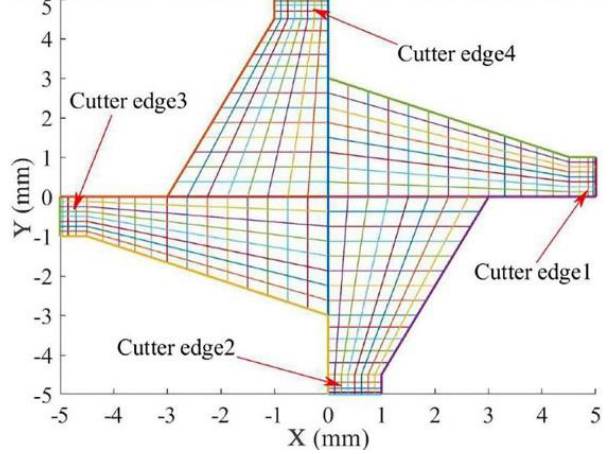
Figure 9. Simplified section of the four-edged milling cutter perpendicular to its axis.